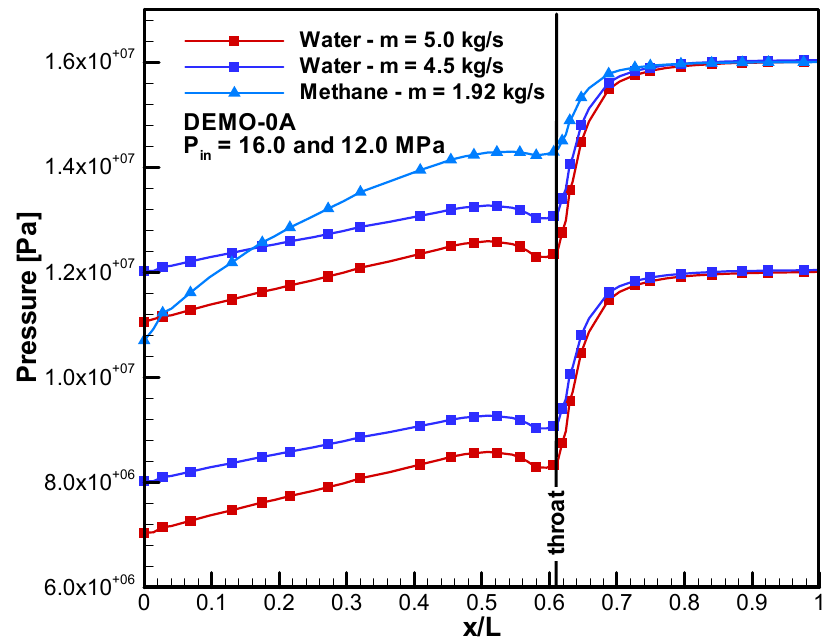
Figure 15. DEMO-0A: axial profiles of static pressure for both methane-cooled (P in = 16.0 MPa) and water-cooled versions (P in = 16.0 MPa and 12.0 MPa).